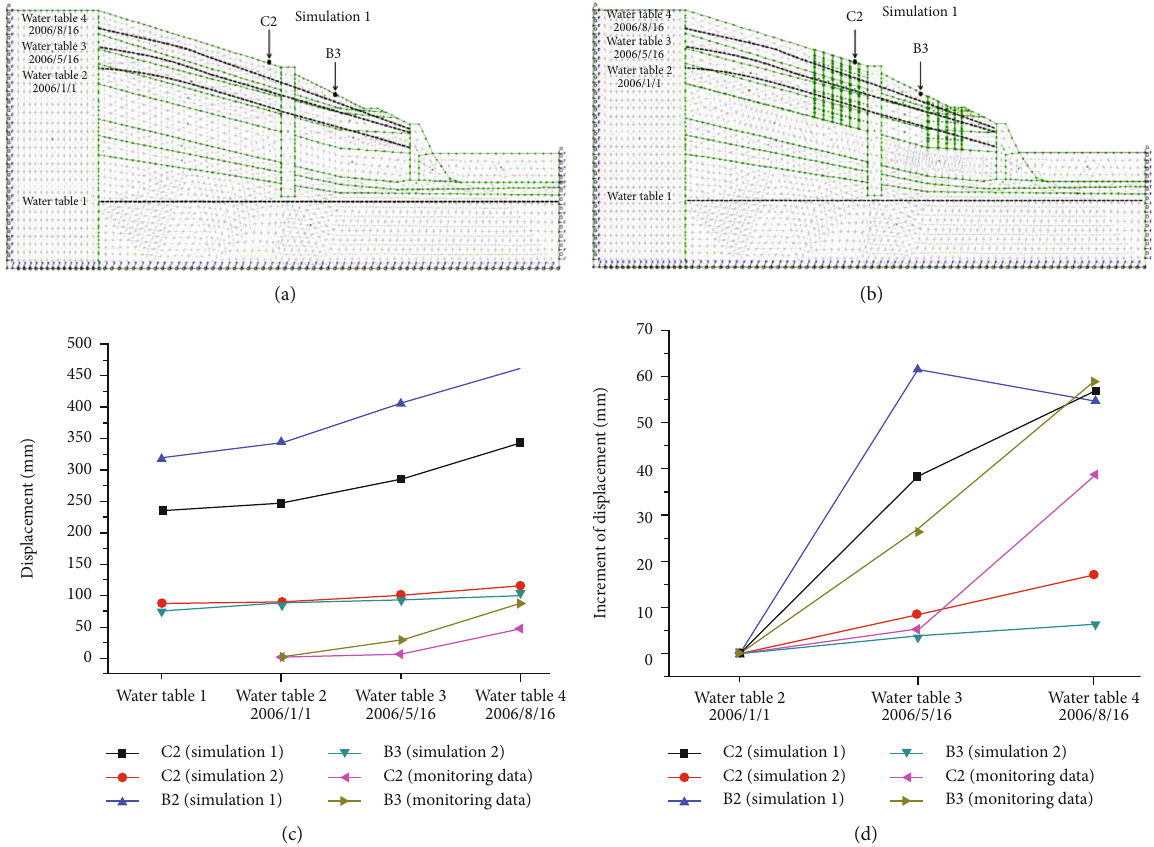
Figure 11: Displacement simulation results considering water level increase: (a) di ff erent water levels in the primary reinforcement condition; (b) di ff erent water levels in second reinforcement condition; (c) displacement versus water table curves; (d) increment curves of displacement.